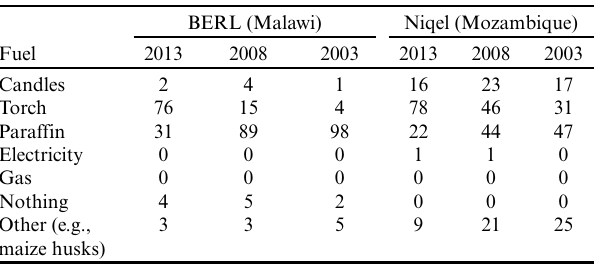
Table 10 . Fuels used for lighting (% of households) †